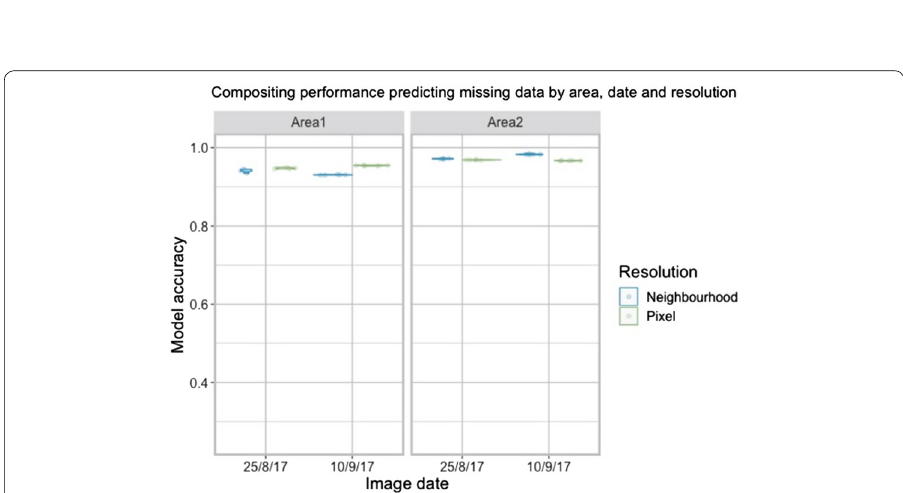
Fig. 12 Compositing performance interpolating land cover class for two areas on 25 August 2017 and 10 September 2017. Neighbourhood scale results are shown by the blue violin plots and pixel scale results are shown by the green violin